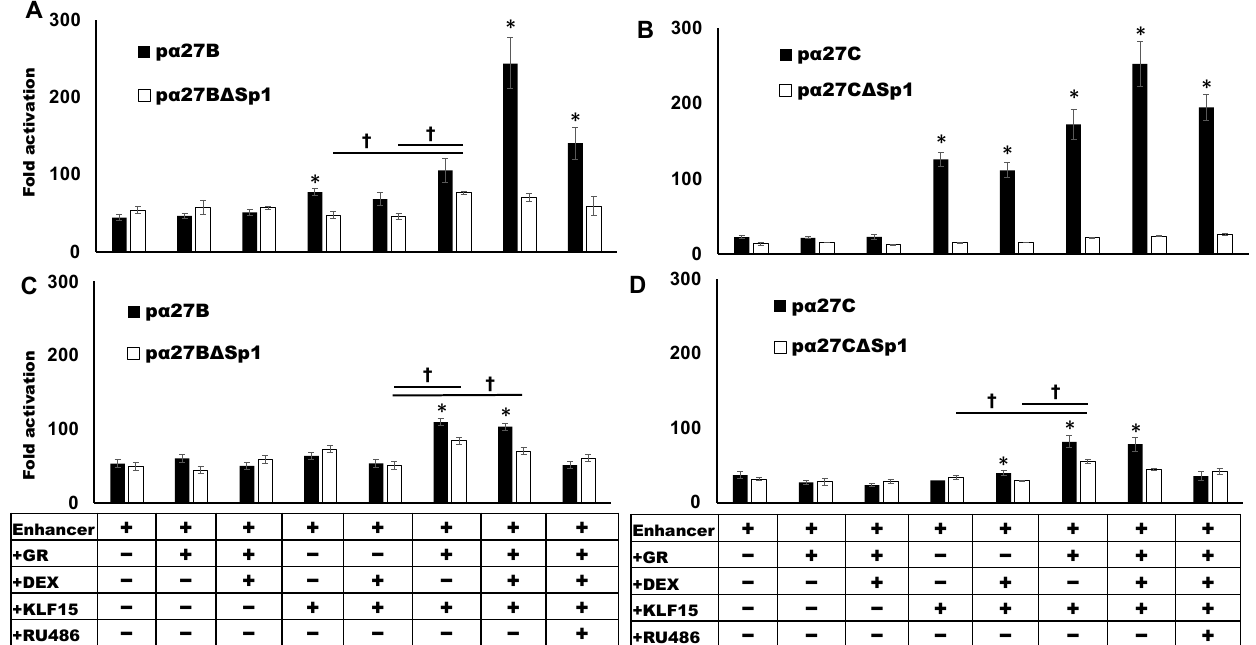
Figure 5. Mutation of Sp1 binding site impairs GR and KLF15-dependent transactivation of ICP27 enhancers. Vero cells (Panels ( A , B )) or Neuro-2A cells (Panels ( C , D )) were cultured in MEM with 2% stripped FBS and transfected with the denoted enhancer fragments (0.5 µg DNA) and a Renilla luciferase expression plasmid (0.05 µg DNA) as a transfection control. The reporter plasmid contained either the wt or Sp1-mutant enhancer fragment, p α 27B (Panel ( A )) or p α 27C (Panel ( B )). Where indicated, cells were co-transfected with a GR (1 µg DNA) or KLF15 (0.5 µg DNA) expression plasmid. Empty vector plasmid was added to maintain equal amounts of DNA in each transfection. Cells were treated with DEX (10 µM) or RU486 (10 µM, mifepristone) at 24 h post transfection and harvested at 48 h post transfection. Enhancer activation was measured, and fold activation was calculated. The results represent the mean of three separate experiments, and error bars indicate standard error. An asterisk ( * ) indicates a significant change in promoter activity between the wild-type and Sp1-null enhancer fragment. A dagger ( † ) denotes a significant difference between indicated samples, as determined by Student’s t-test ( p < 0.05).